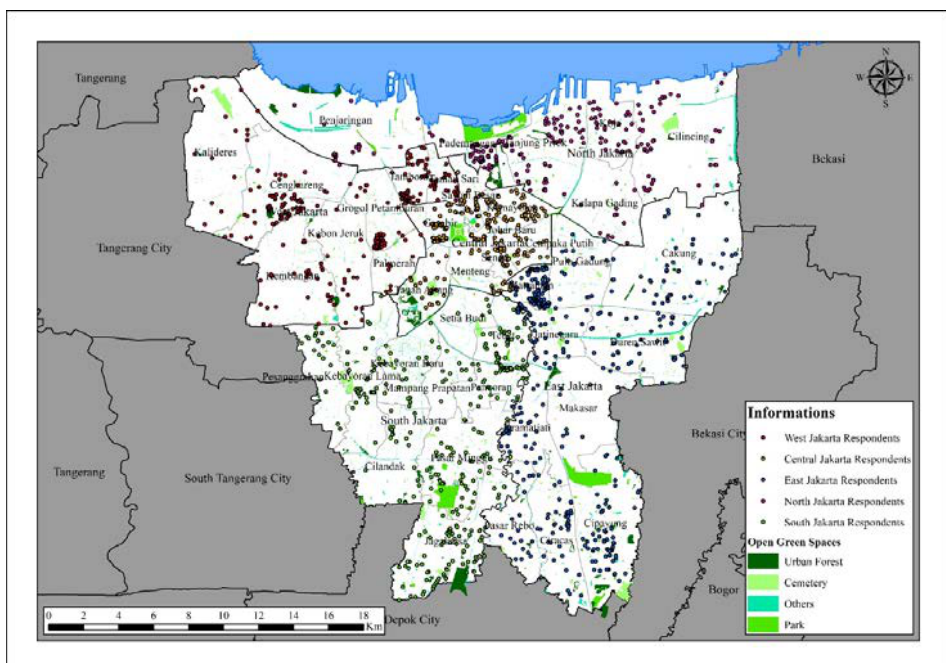
Fig. 2: Distribution of respondents and UGS in Jakarta Province, Indonesia